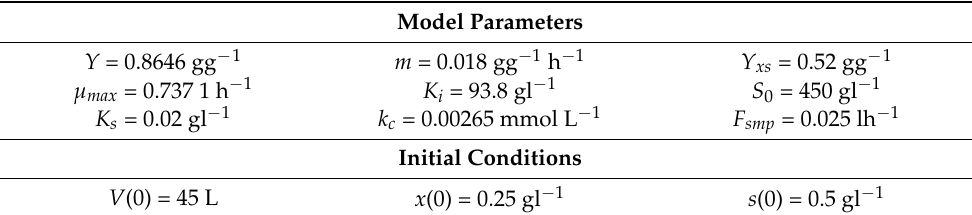
Table 2. Biotechnological model parameter values and initial values of the state variables. Model Parameters